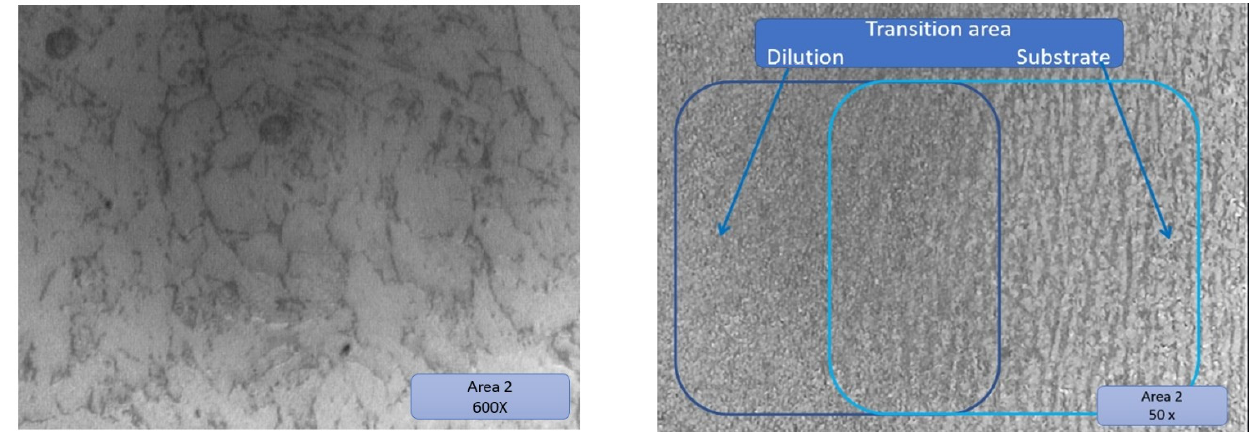
Figure 24. Substrate material area 1.